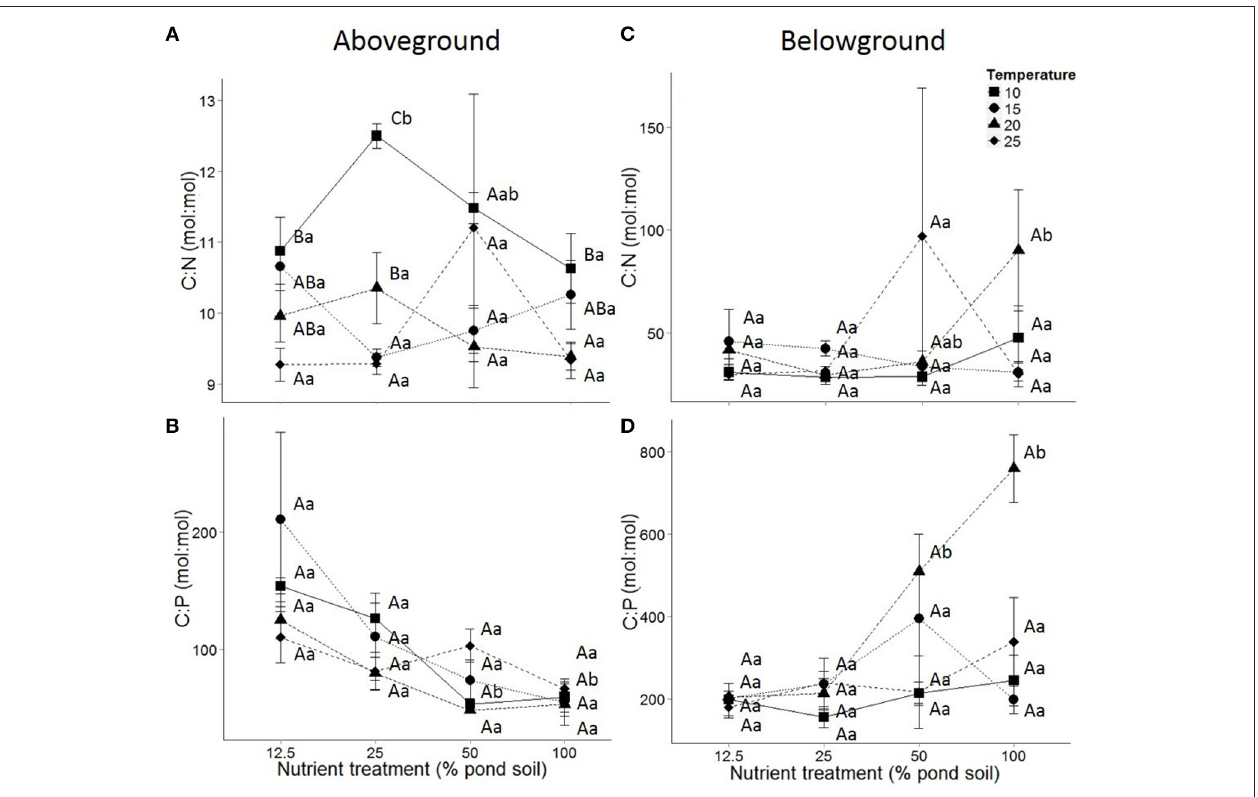
FIGURE 2 | Above—(A,B) and belowground (C,D) carbon:nutrient stoichiometry of Elodea nuttallii in response to sediment nutrient content, with (A,C) C:N and (B,D) C:P ratios. Temperature treatments include 10 ( (cid:4) ), 15 ( • ), 20 ( N ) and 25 ( (cid:7) ) ◦ C. Dots represent means and error bars standard error of the mean. Capital and lower case letters indicate post-hoc differences between temperature and nutrient treatments,